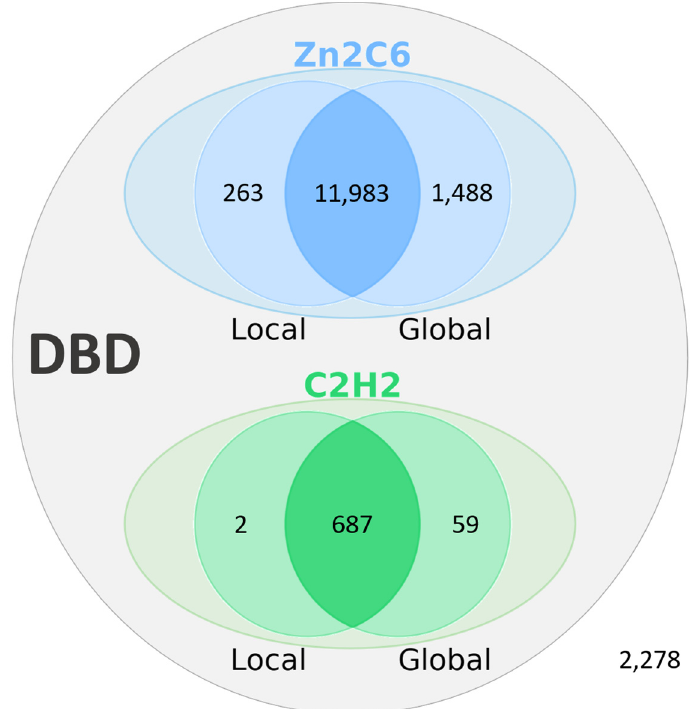
Figure 5. Results of the error identification step in 16,760 MHD-only TF sequences from the TrEMBL database. Number of DBD (Zn2C6 or C2H2) identified by local and global alignment methods. A total of 14,482 MHD-only TF sequences could be attributed to gene prediction errors, while no DBD could be identified for the remaining 2278 sequences.